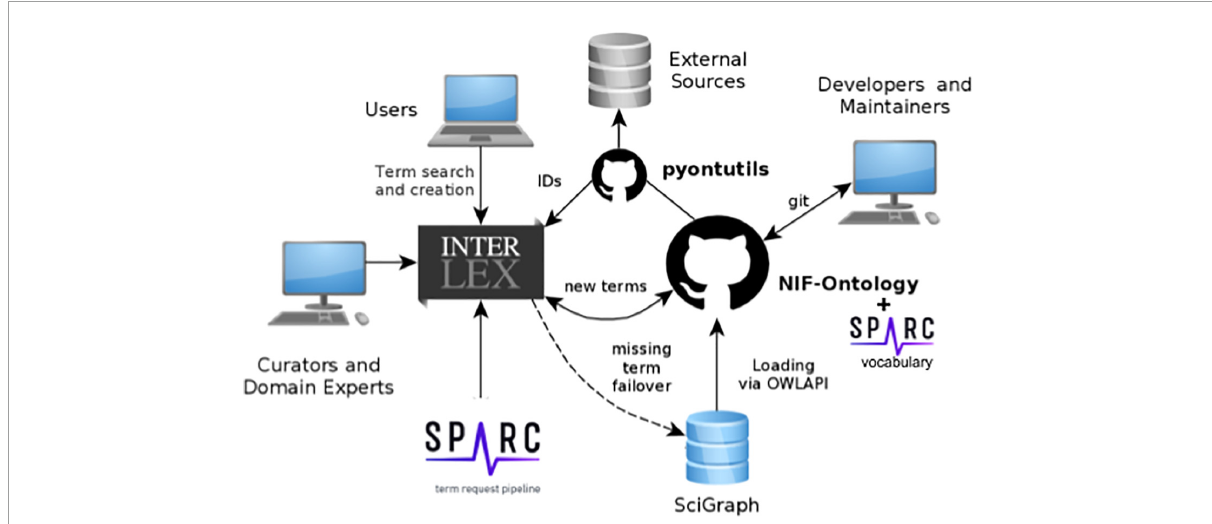
FIGURE1 Schematic diagram of SciCrunch vocabulary infrastructure showing how content is managed across the different components. Different types of users interact with the system via different